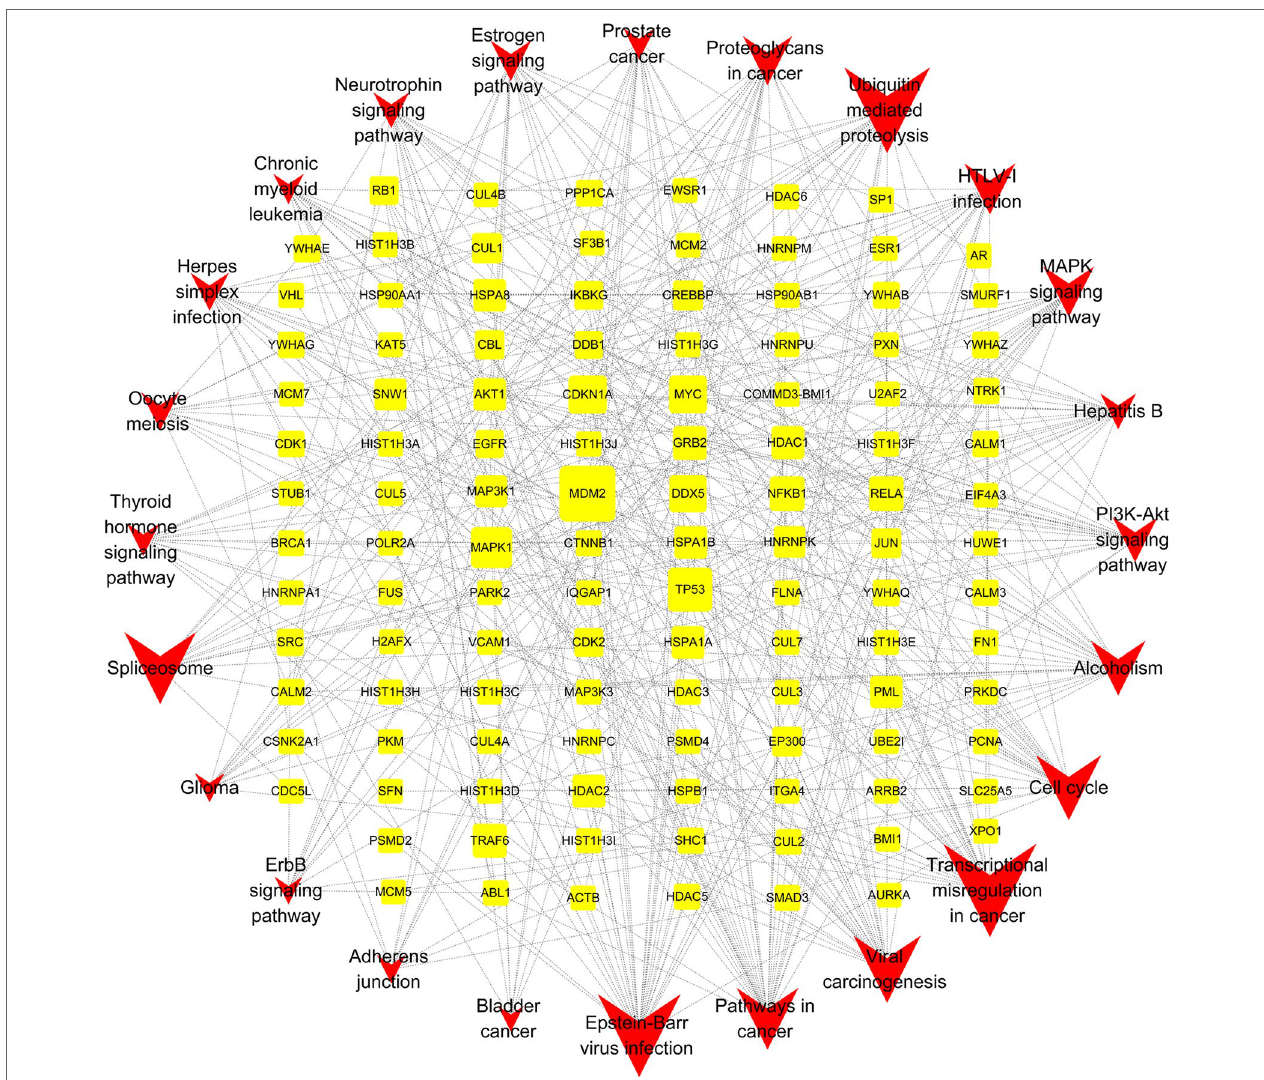
FIgUrE 6 | Gene-Pathway Network of YQSX against ITP. The topological analysis of 24 pathways and 115 genes was carried out with betweenness centrality. The yellow squares represent target genes and the red V-shapes represent pathways. Big size represents the larger betweenness centrality.